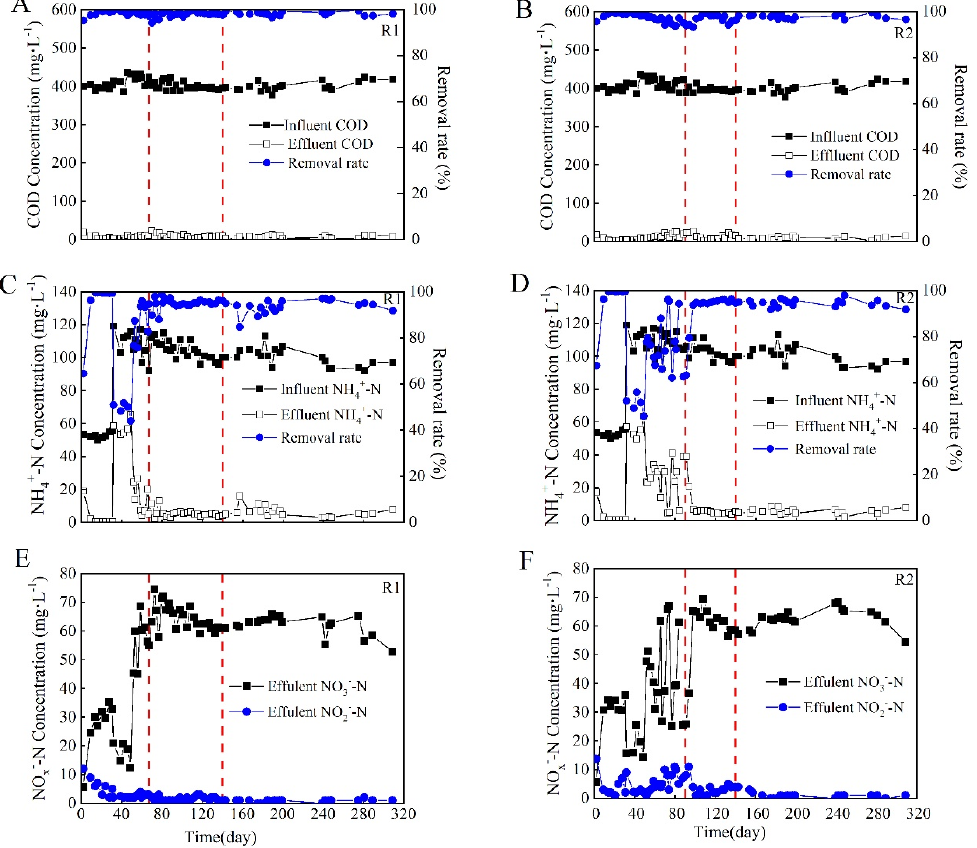
Figure 5. Performance of the aerobic granules over the operation period in R1 and R2. ( A , B ), COD removal in R1 and R2, respectively; ( C , D ), ammonium removal in R1 and R2, respectively; ( E , F ), NO X formation in R1 and R2,